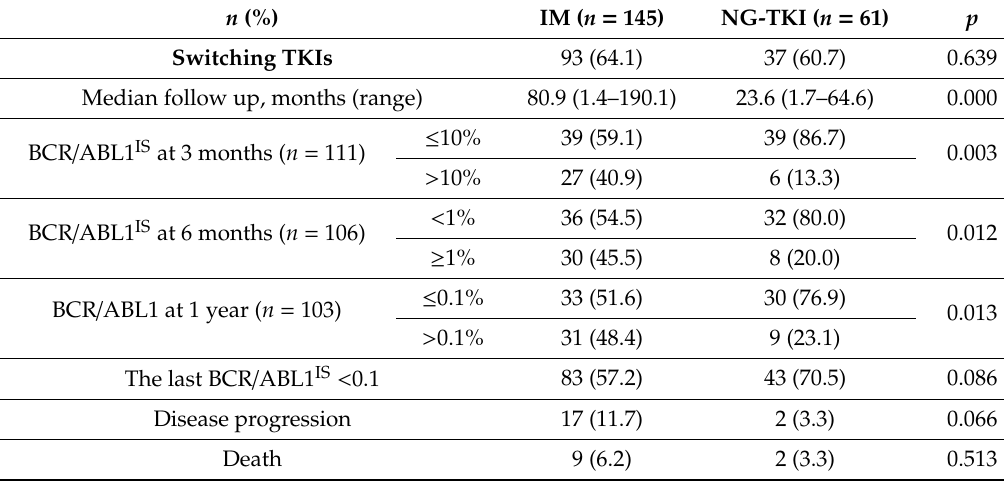
Table 2. Outcomes according to the front line tyrosine kinase inhibitor, Imatinib vs. newer generation tyrosine kinase